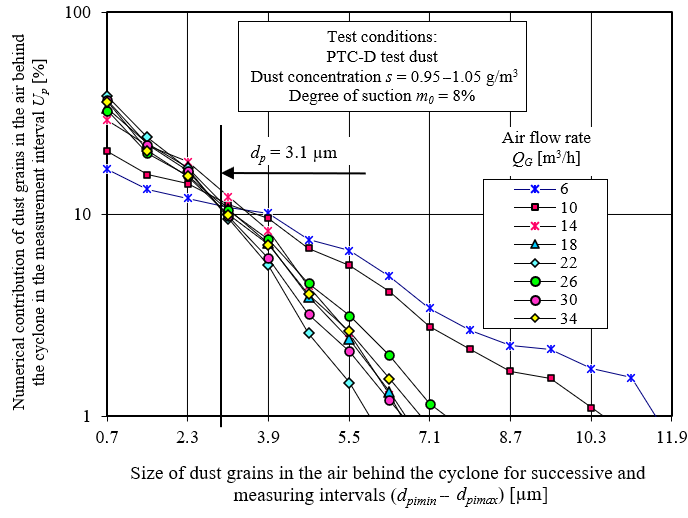
Figure 35. Numerical contribution of U p of dust grains in the air behind the tested cyclone D -40 (cyclone No. 1 — original version) for different values of air flow Q G .